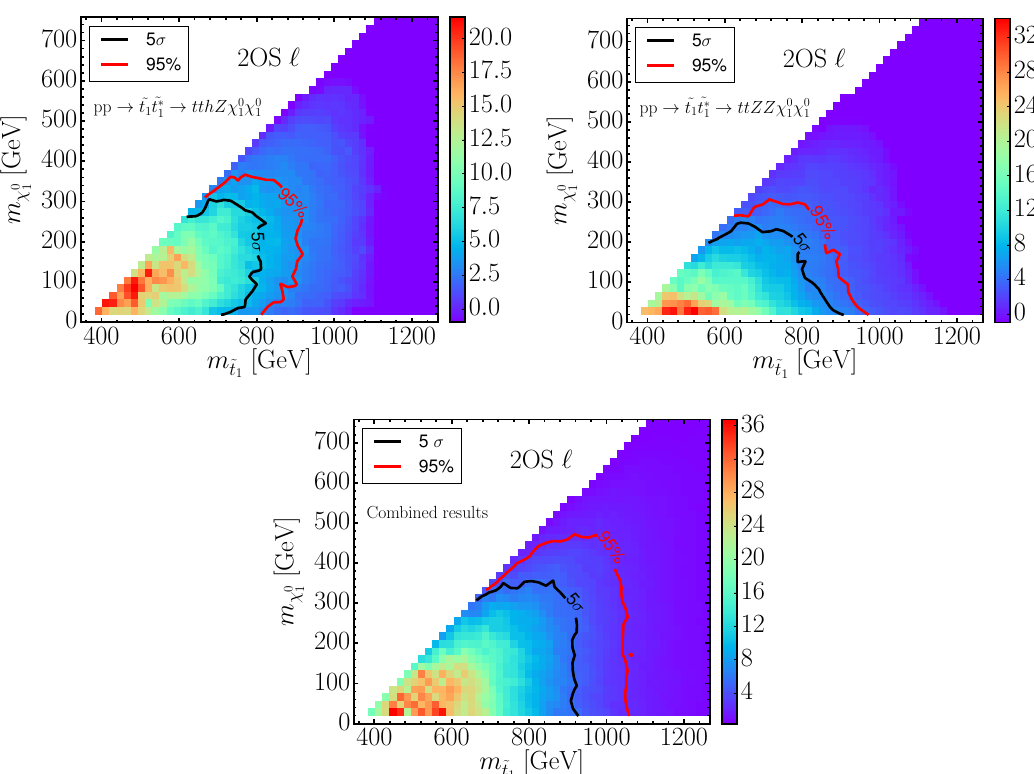
Figure 6 . The 95% C.L. upper limits (black) and 5 (cid:27) discovery reach (red) are shown in the plane of MSSM parameter space m ~ (top left) and t (cid:22) tZZ at 14 TeV LHC with 300 fb (cid:0) 1 integrated luminosity.